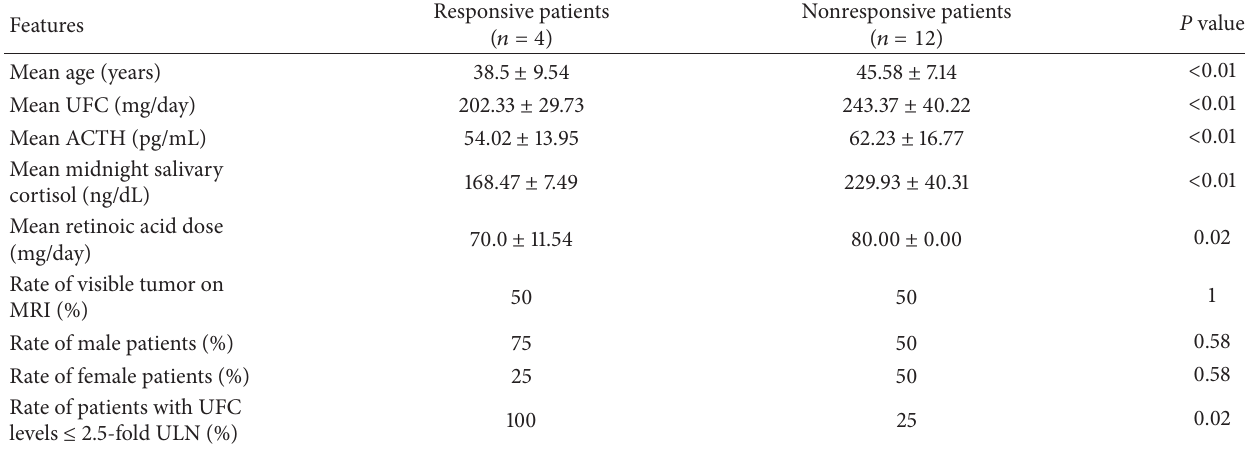
Table 2: Comparison of responsive and nonresponsive patients.